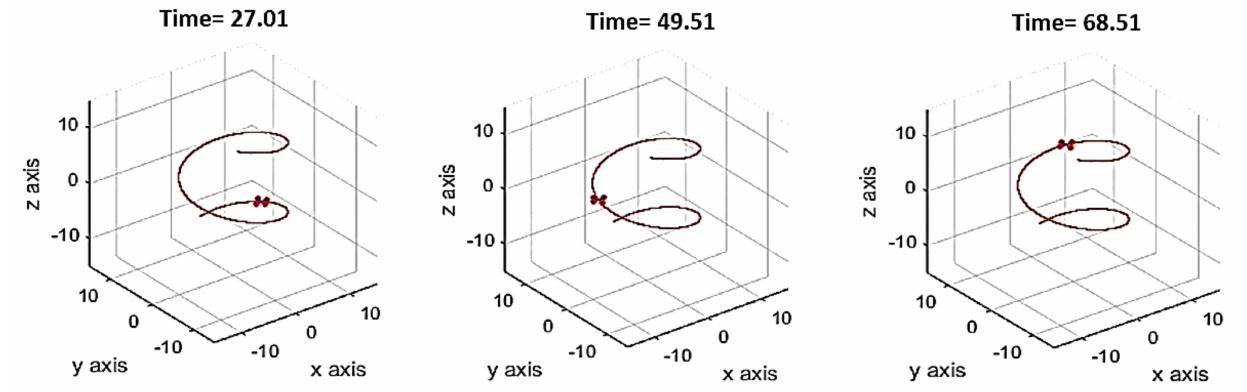
Figure 4. Helical trajectory tracking using Backstepping control under no